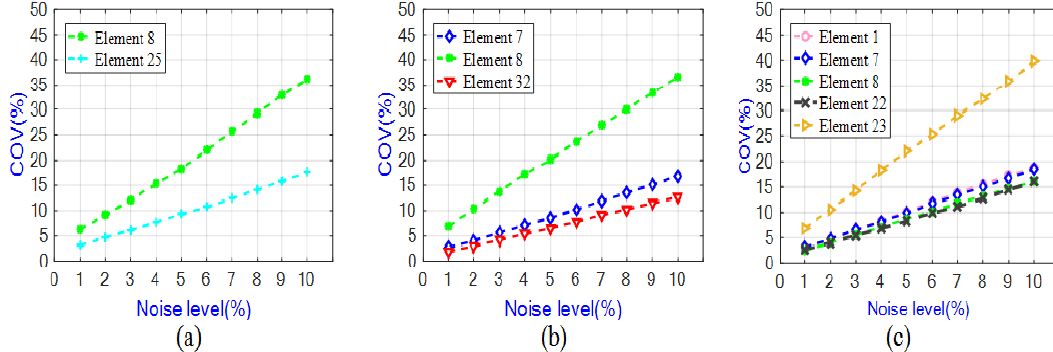
Fig. 5. Coe(cid:30)cients of variances for damaged elements in the case of di(cid:27)erent noise levels: (a) Scenario D; (b) Scenario E; (c) Scenario